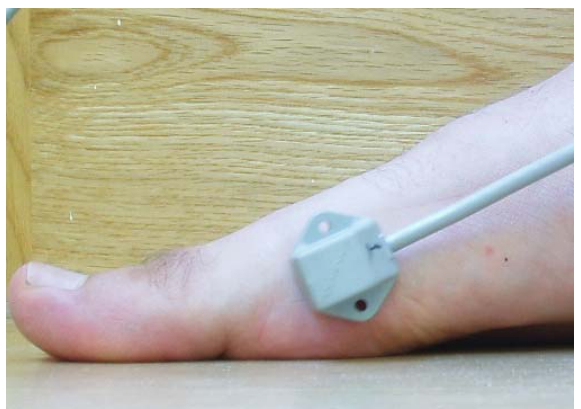
Figure 2. Sensor one. Location placed on the medial head of first metatarsal bone.